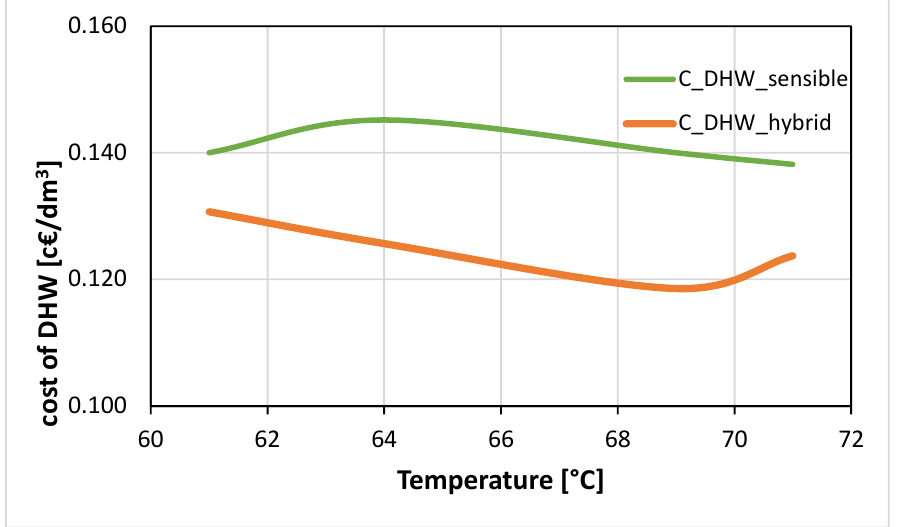
Figure 12. Results of the economic analysis.